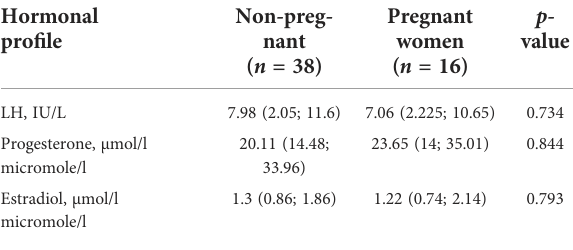
TABLE 5 LH, estradiol, and progesterone concentrations in follicular fl uid in pregnant and non-pregnant